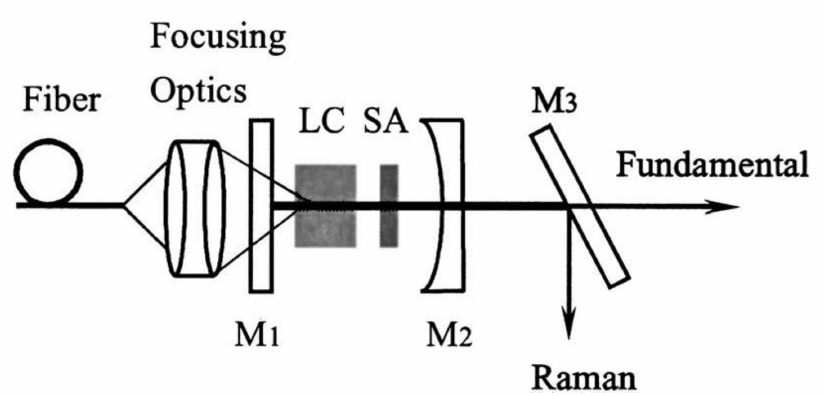
Figure 5. Schematic diagram of the PQS Yb:KLuW self-Raman laser setup; LC, laser crystal; SA, saturable absorber [101].